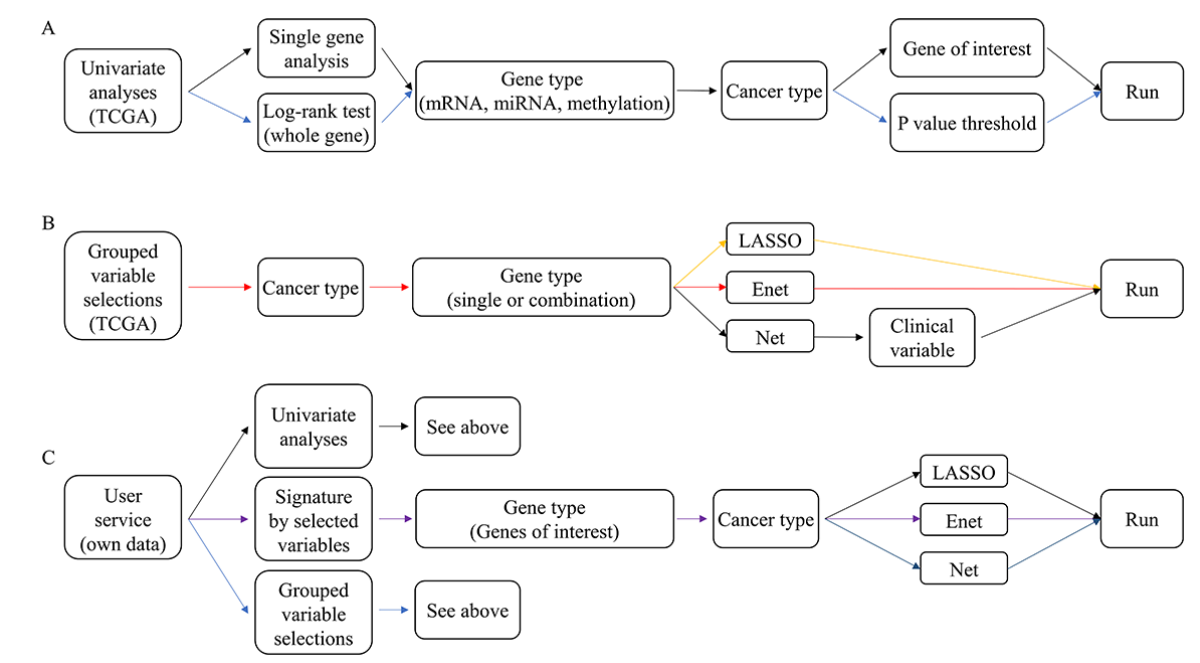
Figure 1. The running procedure of